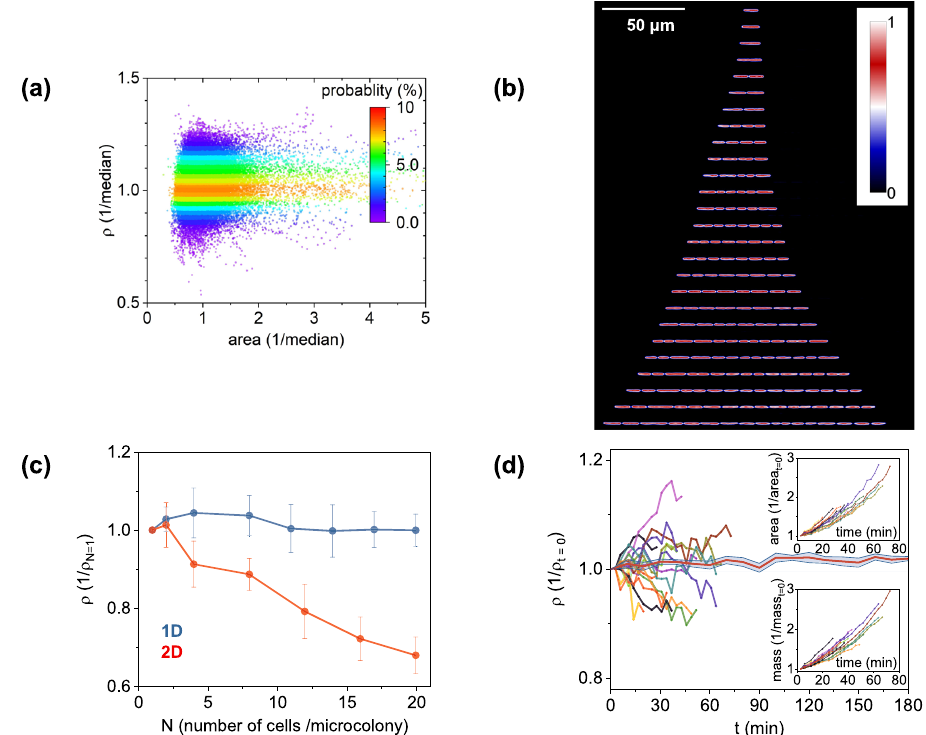
Fig. 1 Quantitative-mass imaging and “ invisible ” micro fl uidics reveal cell-to-cell variability in dry-density and density fl uctuations during growth. a Cell-to-cell dry-density plotted as a function of cell size; graph plots single-cell snapshot data at various stages along the growth cycle ( n = 35,000 observations). b Microcolony expansion from one cell to four generations via quantitative-mass imaging; the vertical direction, with color coding representing cell density (normalized at t = 0, where N = 1). c Microcolony density (normalized at t = 0, N = 1) during expansion using 1D and 2D growth assays; data points and error-bars represent the average and standard deviation of n = 8 independent measurements; time-dependent density differences in 2D were statistically signi fi cant (one-way ANOVA, F(6,49) = 51.8, p « 0.001); no such evidence was found for the 1D assays (one-way ANOVA, F(7,56) = 0.8 and p = 0.5). d Density, mass, and area growth curves of individual E. coli cells from birth to division; all parameters are normalized at t = 0 and color coding represents the size, mass, and density of the same cell (i.e., the curves do not represent the dynamics of multiple cells pooled together); the horizontal red line denotes the dynamics of the normalized density (with respect to t = 0) of 10 fi xed E. coli cells (DH5 α , fi xed by overnight incubation in 2% glutaraldehyde, followed by 3× PBS washing) over time (red line denotes the average and blue-shaded area denotes the 95% con fi dence